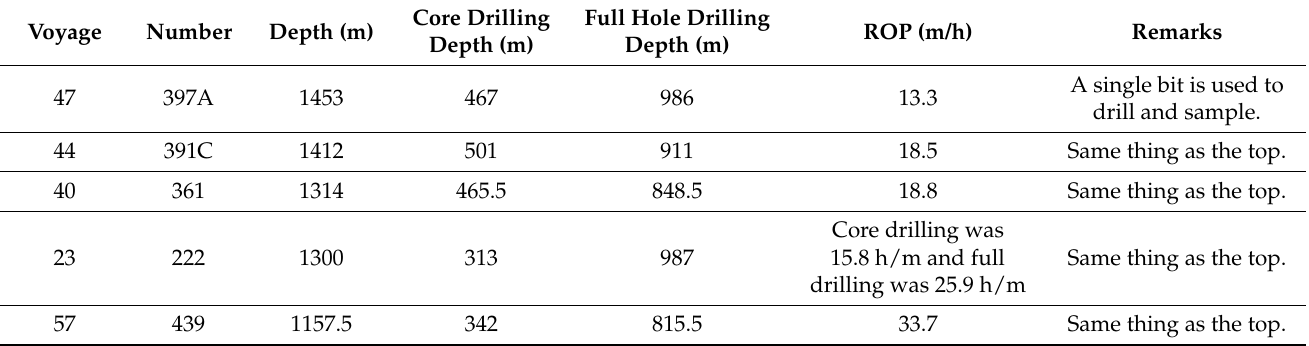
Table 1. The ROP and bit life for deep holes in sediments in international ocean drilling (data were from preliminary report for each DSDP, ODP and IODP expedition).